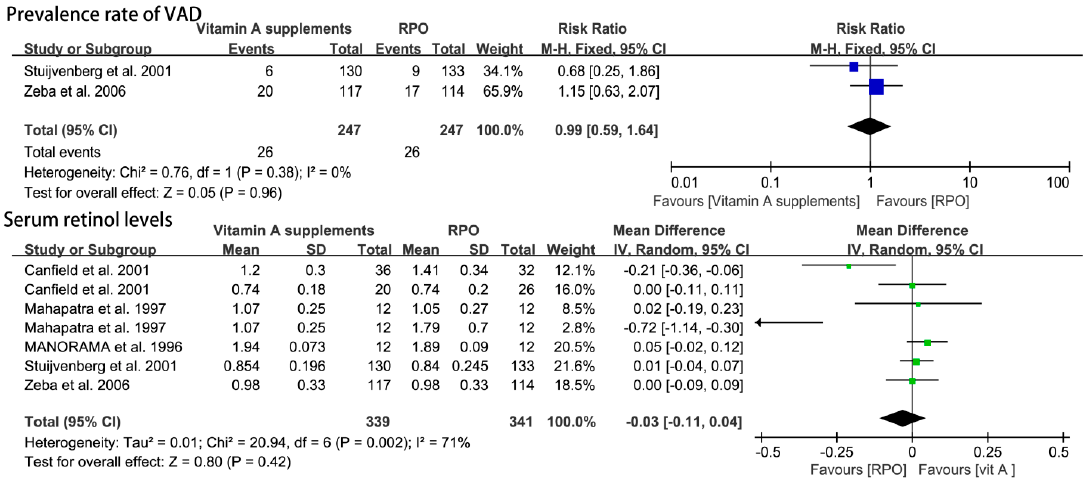
Figure 8. Comparisons of the prevalence rate of vitamin A deficiency (VAD) and serum retinol levels ( μ mol/L) following red palm oil (RPO) and vitamin A supplement intervention. CI: confidence interval.